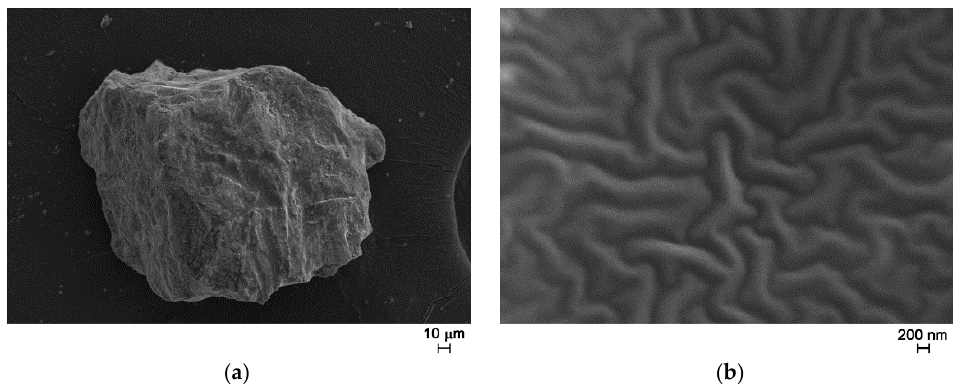
Figure 7. FE-SEM micrographs of as prepared glass ceramic, magnification = 1000× ( a ); 50,000× ( b )